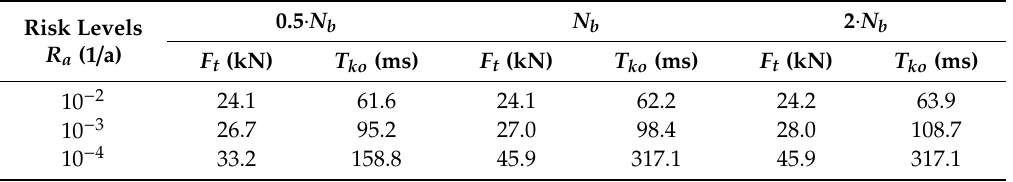
Table 7. Force F t values and corresponding T ko values for defined risk levels and different values of protection and circuit-breaker failure rates; fault conditions at point A.